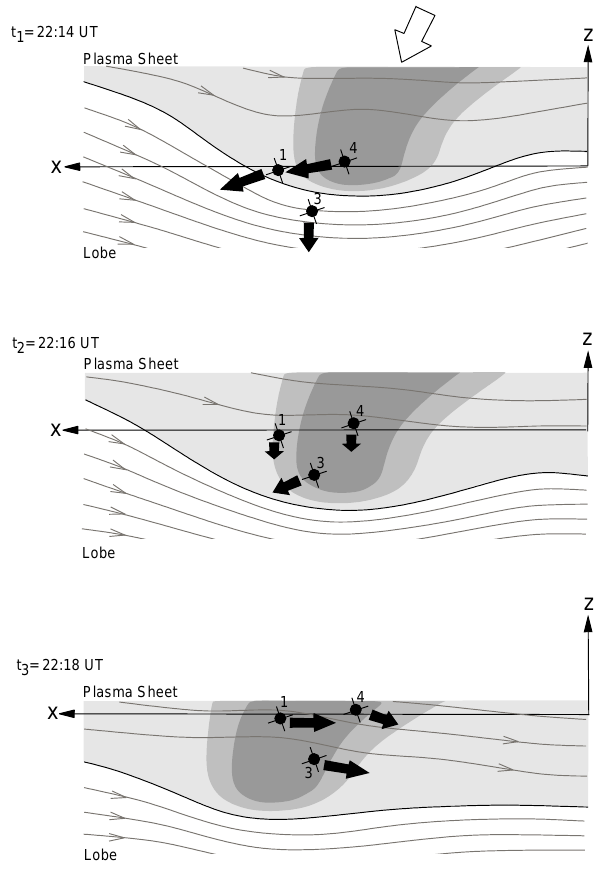
Fig. 9. A possible scenario for the evolution of CGR1. See the text for an